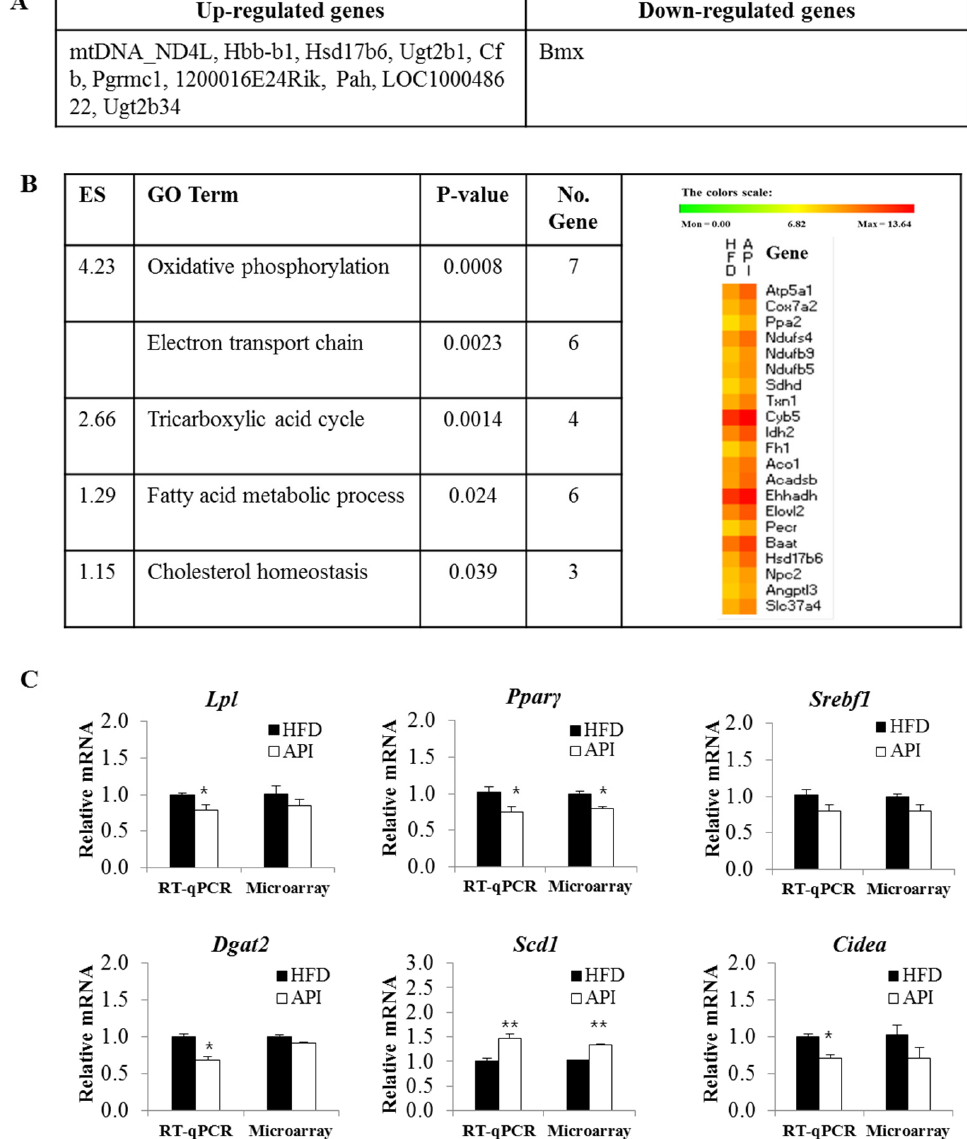
Figure 5. The top 10 most upregulated and downregulated genes in the livers of the apigenin group compared to the control group ( A ); functional gene ontologies associated with the apigenin-responsive genes ( B ); and real-time quantitative PCR validation ( C ); ( A , B ) comparison of differentially-expressed genes in the apigenin group vs. the control group using Benjamin–Hochberg adjusted p -value < 0.05, FDR (False Discovery Rate) <5%, fold change >1; ( B ) functional gene ontology terms enriched among apigenin responsive genes are clustered according to biological processes (enrichment score >1) using DAVID. The heatmap shows the expression profiles of the representative apigenin responsive genes in each cluster; ( C ) Data are shown as the means ± S.E. Values are significantly different between the high ‐ fat diet and apigenin groups according to Student’s t ‐ test: * p < 0.05; ** p < 0.05. Microarray data based on pooled RNA hybridized to Illumina MouseWG ‐ 6 v2.0 BeadChips. HFD: high ‐ fat diet (20% fat, 1% cholesterol); API: HFD + 0.005% Apigenin; Lpl: lipoprotein lipase; Ppar γ : peroxisome proliferator ‐ activated receptor γ ; Srebf1: sterol regulatory element ‐ binding transcription factor 1; Dgat2: diacylglycerol O ‐ acyltransferase 2; Scd1: stearoyl ‐ CoA desaturase ‐ 1; Cidea: cell death activator; ES: Enrichment Score.